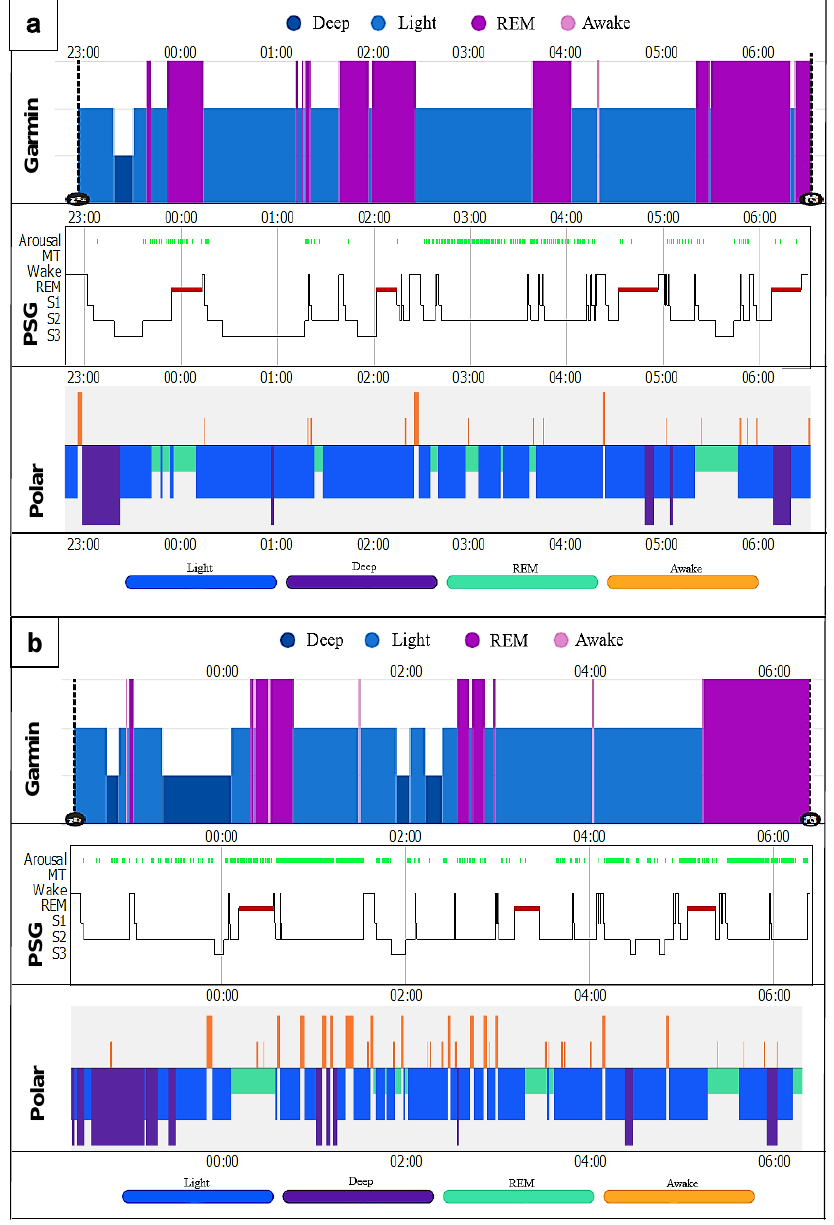
Figure 5. Night sleep hypnograms (Garmin, PSG, Polar); ( a ) CPAP patient (male); ( b ) sleep patient (female). Arousal = partial, temporary or complete wake-up reaction with sleep-disrupting effect [66]; MT = movement time; Wake = awake time; REM = rapid eye movement sleep; S1–S3 represent NREM1–NREM3 (N1 + 2 = light sleep; N3 = deep sleep [70]). x -axis represents the time in hours; y -axis represents the respective sleep stage.